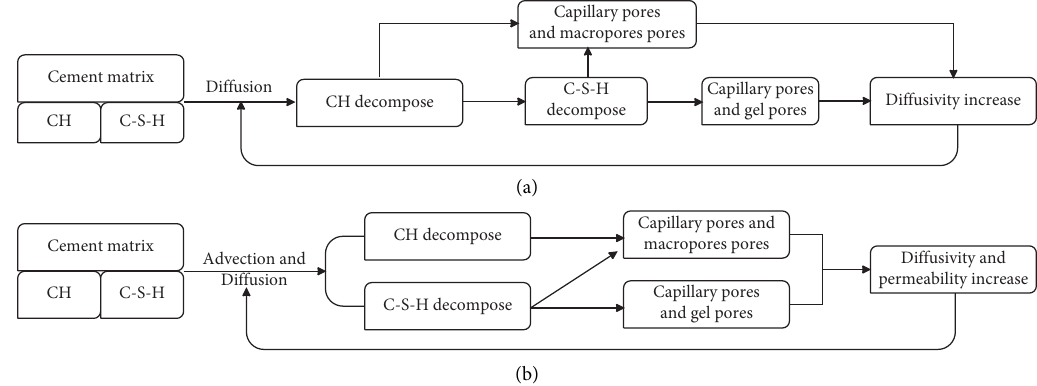
Figure 3: Phenomena of the calcium leaching process under equilibrium and nonequilibrium conditions. (a) Calcium leaching in solid- liquid equilibrium condition. (b) Calcium leaching in solid-liquid nonequilibrium